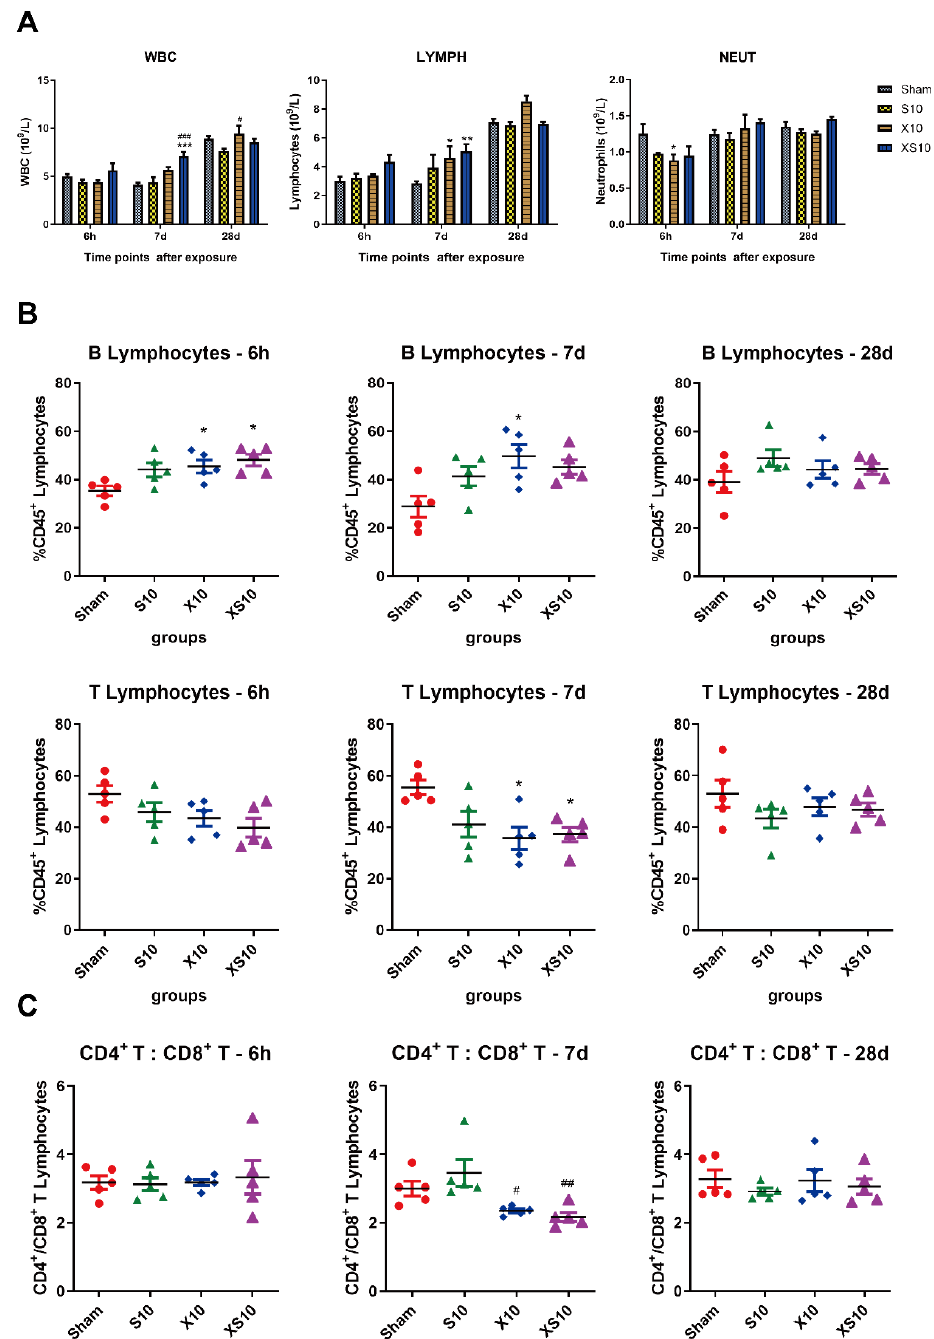
Figure 2. Microwaves regulated the balance of immune cells in the peripheral blood. At 6 h, 7 d and 28 d after microwave exposure, rats from the Sham, S10, X10 and XS10 groups were anesthetized, and anticoagulated blood samples were collected from the inferior vena cava (IVC). The white blood cells (WBC), lymphocytes (LYMPH) and neutrophils (NEUT) were counted ( A ). The immune phenotypes of the lymphocytes were analyzed by flow cytometry, and the percentage of T and B lymphocytes among the total lymphocytes was calculated ( B ). Moreover, the subtypes of T lymphocytes, including CD4 + and CD8 + T lymphocytes were also detected by flow cytometry, and the proportion of total T lymphocytes was calculated ( C ). Data are presented as mean ± s.e.m.; *, p < 0.05, **, p < 0.01, ***, p < 0.001 vs. Sham group; #, p < 0.05, ##, p < 0.01, ###, p < 0.001 vs. S10